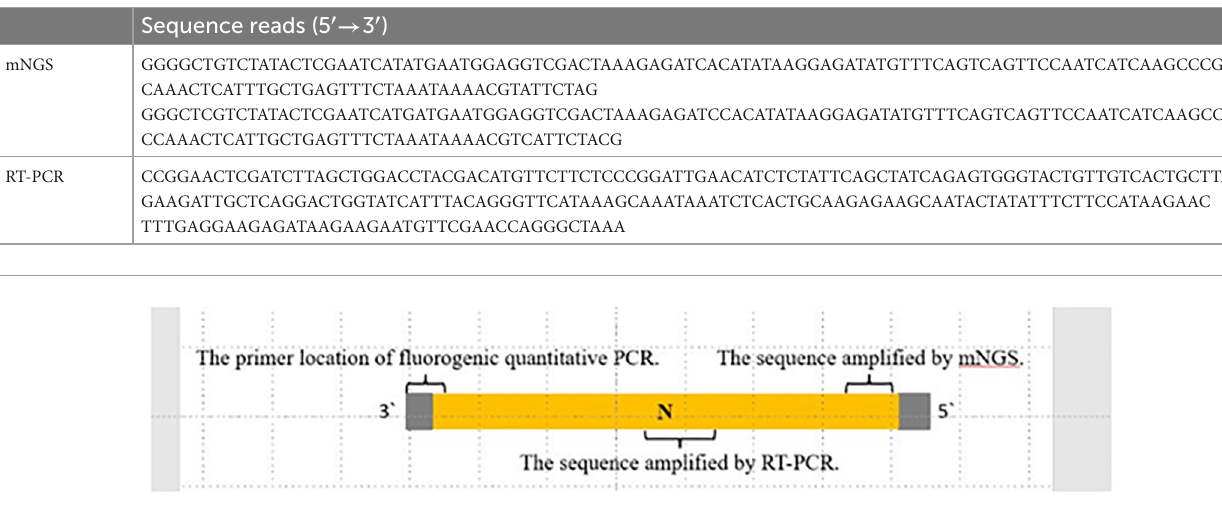
TABLE 1 Sequence reads related to rabies virus by mNGS and RT-PCR from the patient.